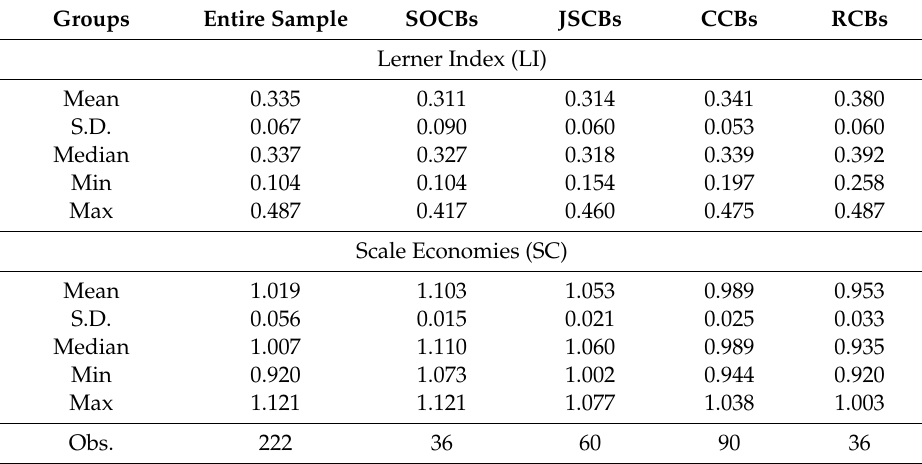
Table 5. Summary statistics of Lerner Index and Scale